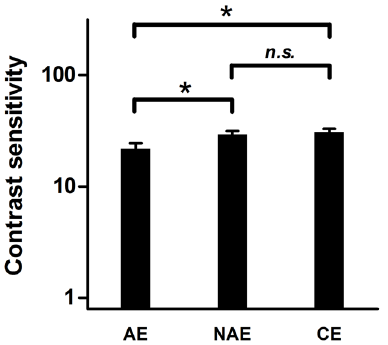
Figure 3. Averaged contrast sensitivity for carriers in ambly- opic eyes, non-amblyopic eyes and control eyes. AE, amblyopic eyes; NAE, non-amblyopic eyes; CE, control eyes. *, statistically significant ( p , 0.05); n.s. , non-significant ( p . 0.05). Error bars represent one standard error of the mean.